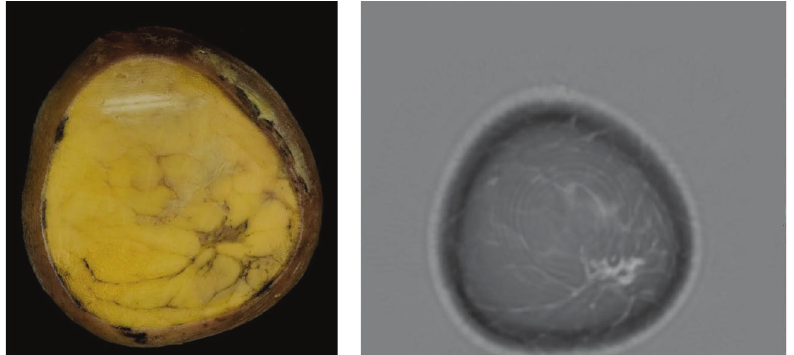
Figure 1: Cadaver cut surface photograph (left) and corresponding transmission (speed of sound) image (right) of the subareolar region. The tissue (dark on the left image and light on the right image) represents ducts, vascular structures, and some supporting connective tissue.